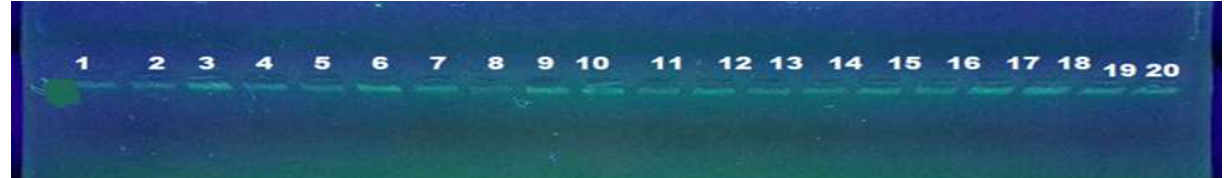
Figure 2: Under UV light and after staining with Red Safe nucleic acid stain, human genomic DNA extraction from whole blood were shown the bands on 1.5% agarose gel at 30 min in gel electrophoresis.